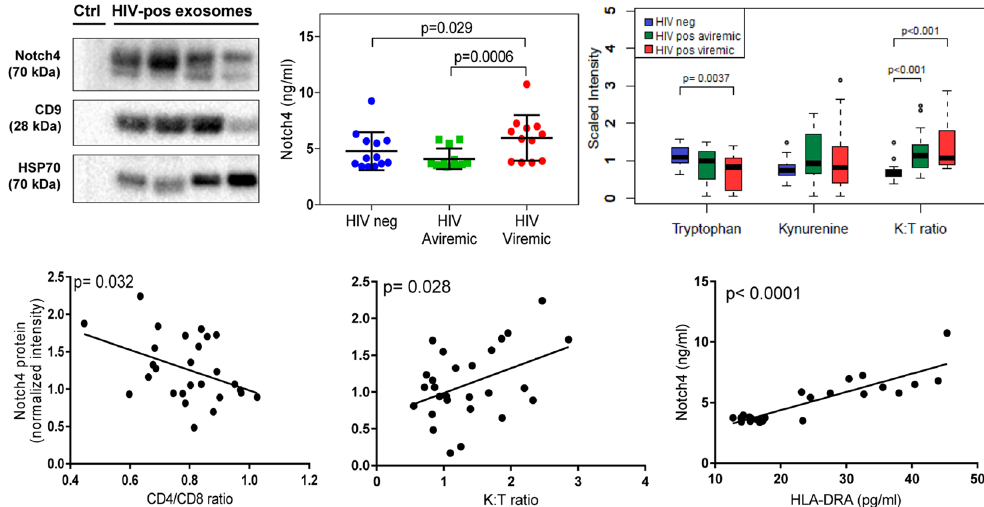
Figure 4. Notch4 protein is detected in plasma exosome fractions from HIV-positive subjects on ART and correlates with immune activation markers. Plasma exosome fraction (25 μ g protein per lane, Ctrl = PBS blank) immunoblotted with Notch4 and exosome marker antibodies (top left). Blots are cropped and full-length blots are included in Supplementary Figure S6. Notch4 protein measured by ELISA in exosome fractions from aviremic and viremic HIV-positive versus HIV-negative subjects (top middle). Horizontal bars represent mean, error bars represent SD. P-values calculated by Mann-Whitney U test. Plasma K:T ratio is increased in aviremic and viremic HIV-positive subjects versus controls (top right). Medians in boxplots are represented by horizontal bars, boxes span the interquartile range (IQR), and whiskers extend to extreme data points within 1.5 times IQR. Outliers are plotted outside 1.5 times IQR. P-values calculated by Welch’s t-test (n = 21 HIV-negative, n = 18 aviremic, and n = 13 viremic HIV-positive subjects). Notch4 levels in HIV-positive plasma exosome fractions correlate negatively with increasing CD4/CD8 ratio and positively with K:T ratio and exosome-HLA- DRA levels in Pearson correlations (bottom panels, p < 0.05; n =